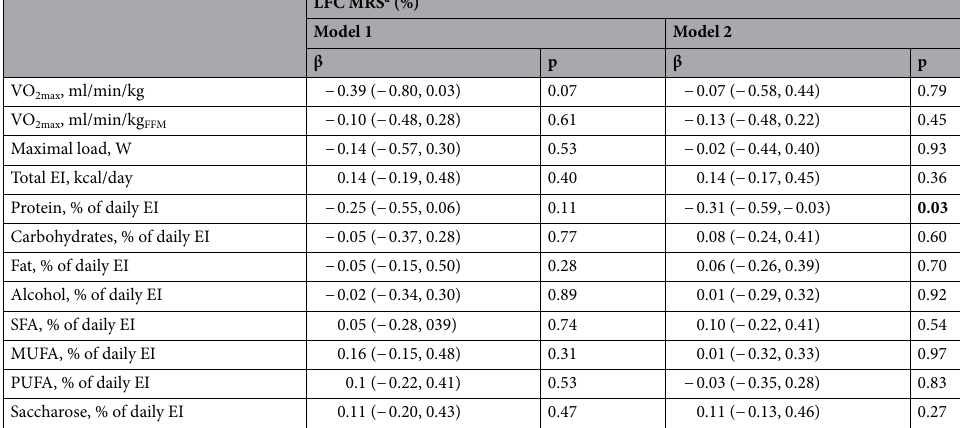
Table 5. Age-, sex- and body fat %-adjusted linear mixed regression estimates (standardized β coefficients (95% CI)) between MRS-measured LFC, fitness and dietary intake. Model 1 adjusted for age and sex. Model 2 adjusted for age, sex and body fat % EI energy intake, FFM fat free mass, LFC liver fat content, MUFA monounsaturated fatty acids, MRI magnetic resonance imaging, MRS magnetic resonance spectroscopy, PUFA polyunsaturated fatty acids, SFA saturated fatty acids, VO 2max maximal oxygen consumption. a log10 transformed variables. Significant values are in